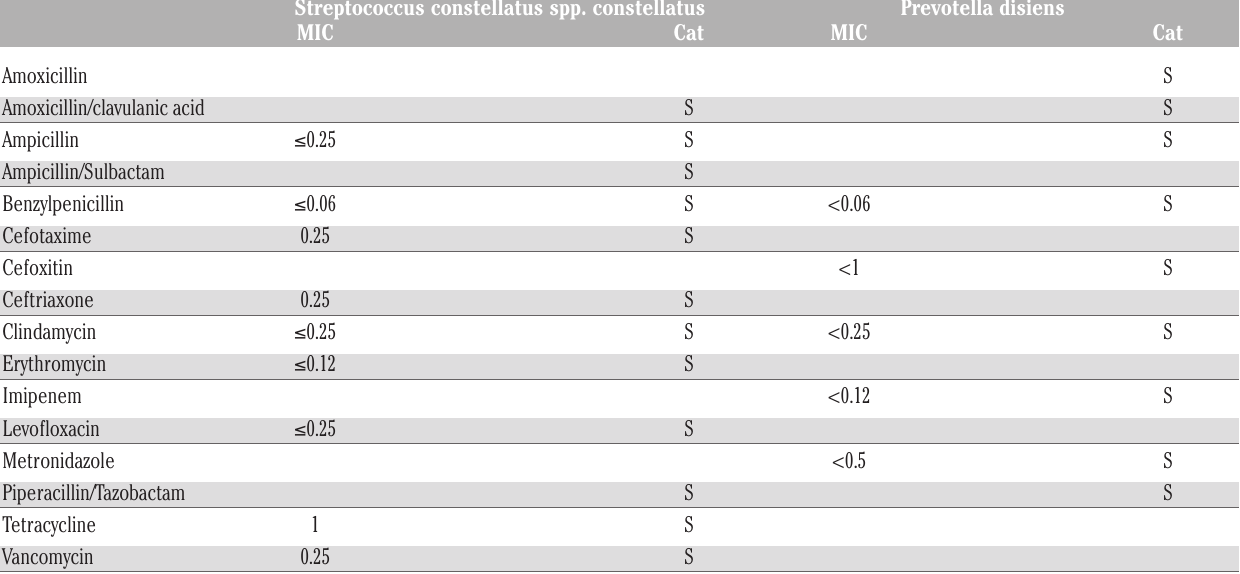
Table 1. Identification for both isolates (performed on automated BIOMÉRIEUX VITEK® 2 SYSTEM). Antimicrobial susceptibility test (AST) was performed: A) for isolate No 1: Streptococcus constellatus spp. constellatus, on automated BIOMÉRIEUX VITEK® 2 Table v. 5.0)